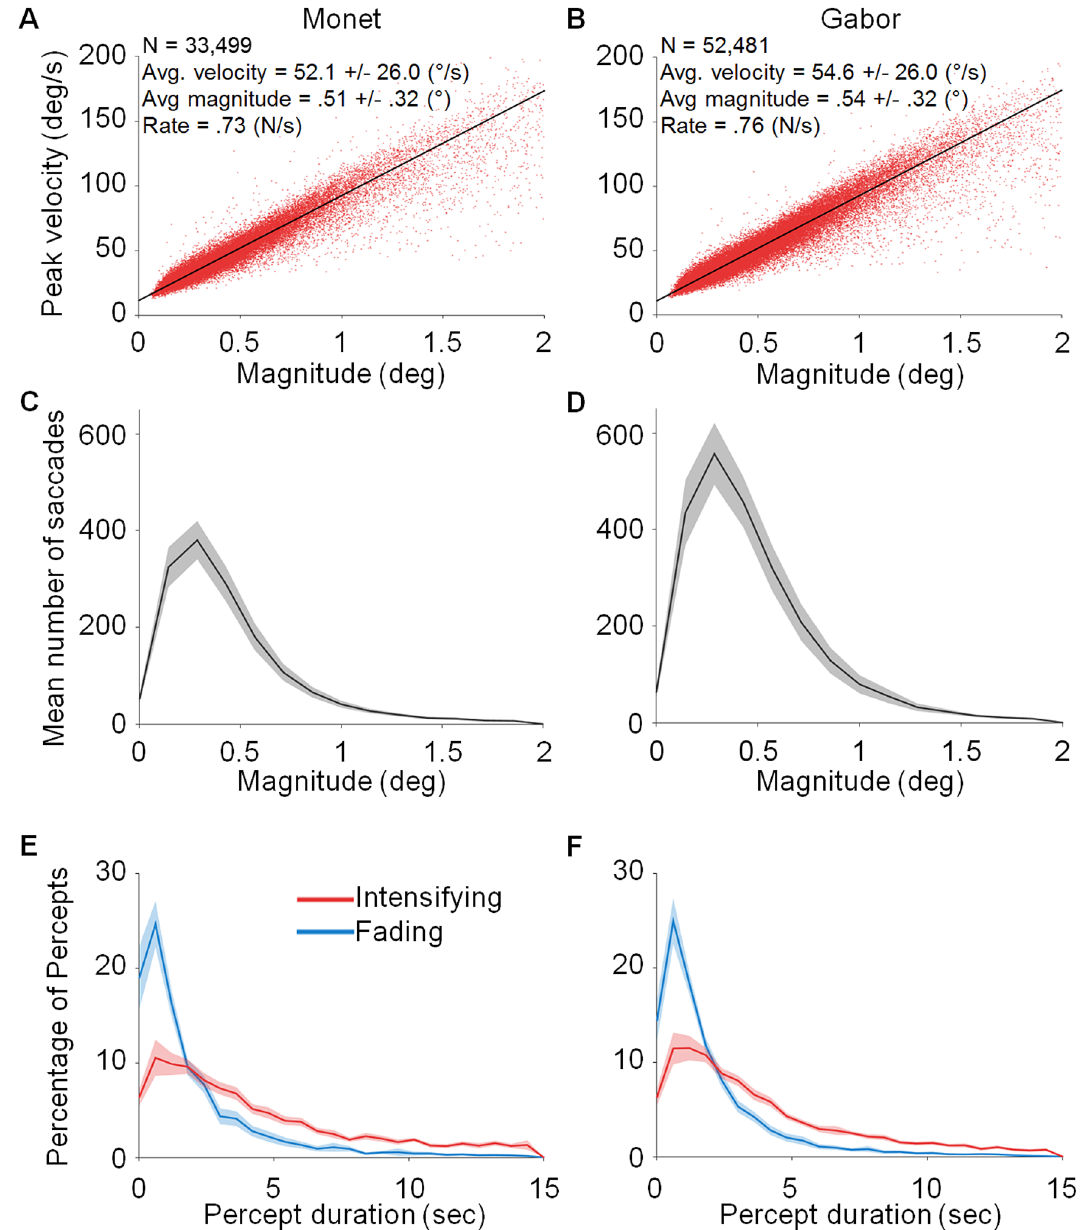
Figure 2. Microsaccade characterization and perceptual reports. ( A,B ) Peak velocity-magnitude relationship for all (micro)saccades with magnitudes < 2°. ( C,D ) Distribution of (micro)saccade magnitudes for the participant average. ( E,F ) Distribution of intensifying (red) and fading (blue) periods during the Monet and Gabor conditions, as indicated by the participants’ report. Shading indicates the SEM across participants. N = 22 participants for each